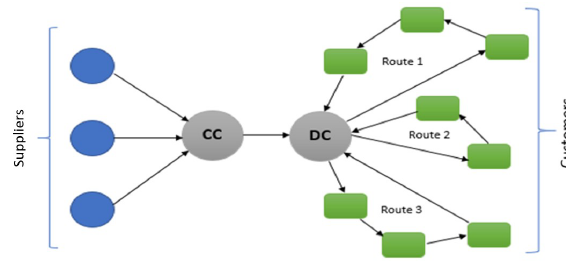
Fig. 3. Collection by CC and distribution by DC